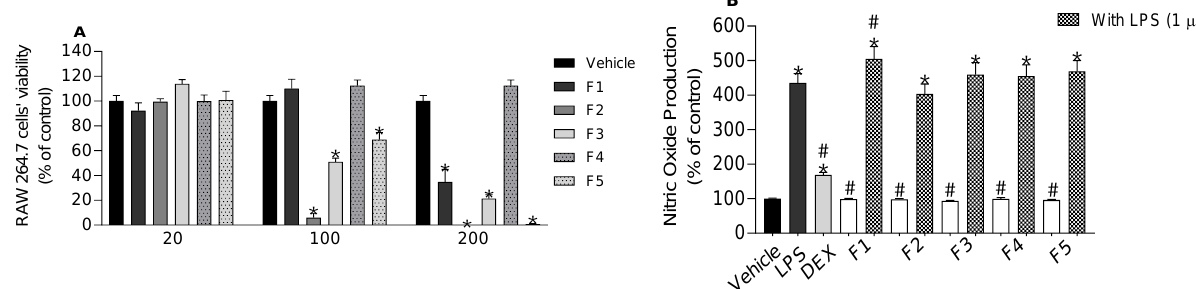
Table 2. Antimicrobial activity (IC 50 , µg/mL) of Saccorhiza polyschides fractions, oxytetracycline and amphotericin B.